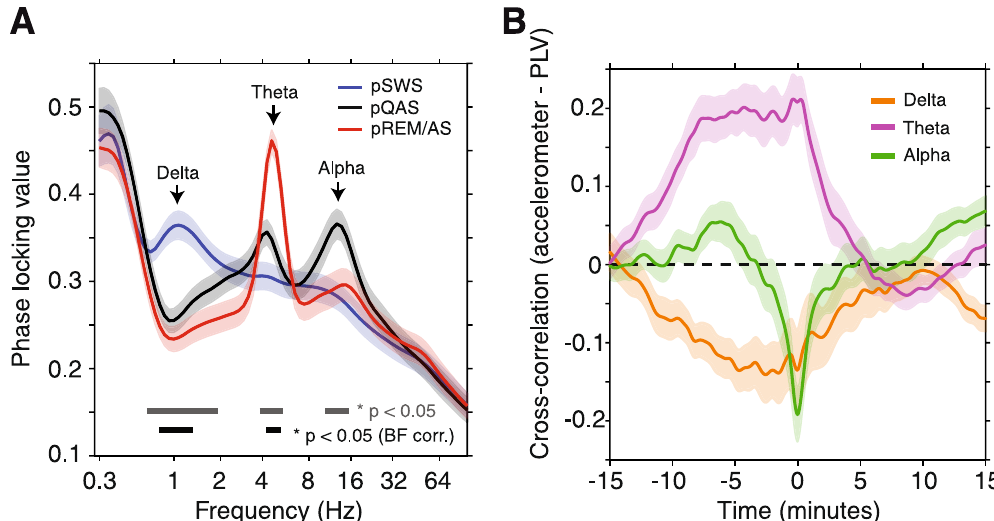
Figure 6. Spectral signatures of cortical synchronization across brain states. ( A ) Population average phase locking value (PLV) computed within each brain state (n = 23 sessions). PLV’s were computed between all pairs of µ ECoG channels to measure patterns of global cortical synchronization. PLV displayed significant state-dependent modulations in the delta, theta, and alpha frequency bands. Significant modulations are shown as bars at the bottom of the plot (gray bar – no correction for multiple comparisons, black bar – Bonferroni corrected p-values, n = 80 frequencies). ( B ) Population average cross-correation of accelerometer and PLV time series for the delta, theta, and alpha carrier frequencies ( ± SEM, n = 23). Note the strong posistive correlation of theta PLV up to 10 minutes prior to movement epochs. Conversley, alpha PLV is negatively correlated in a tight window around movement